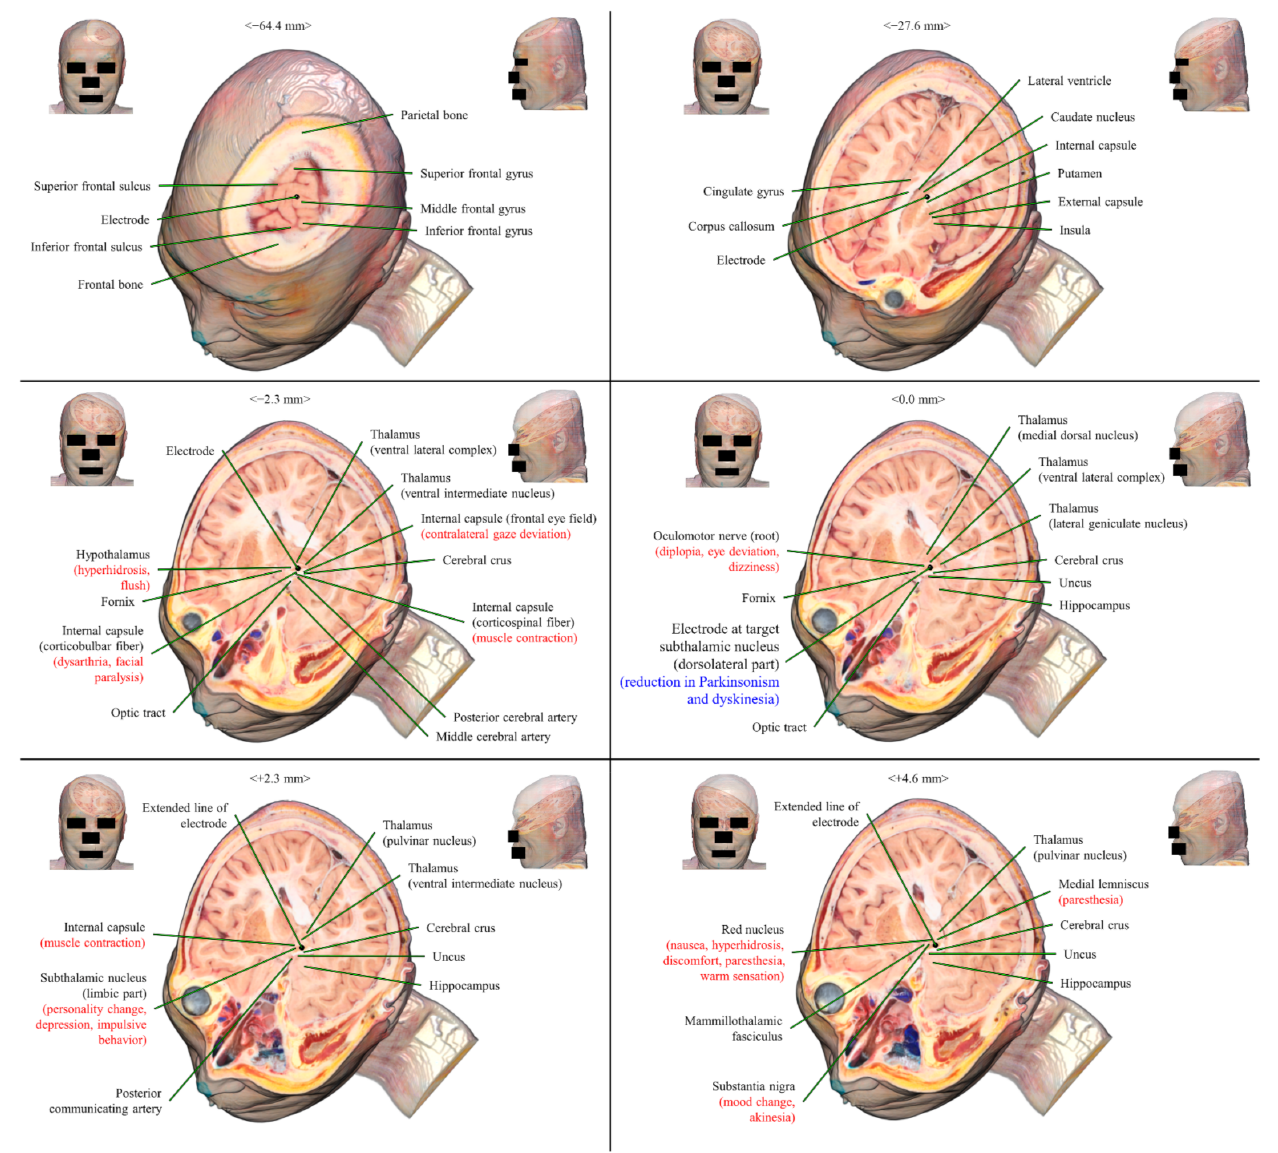
Figure 4. Probe’s eye planes on a real color volume model from the entry point to the target point through the side of the lateral ventricle. The probe’s eye planes are displayed from the entry point (middle frontal gyrus) to the target point (dorsolateral part of the subthalamic nucleus). The curative effects when the electrode is placed at the subthalamic nucleus are written in blue. The adverse effects when the electrode is placed at different structures are written in